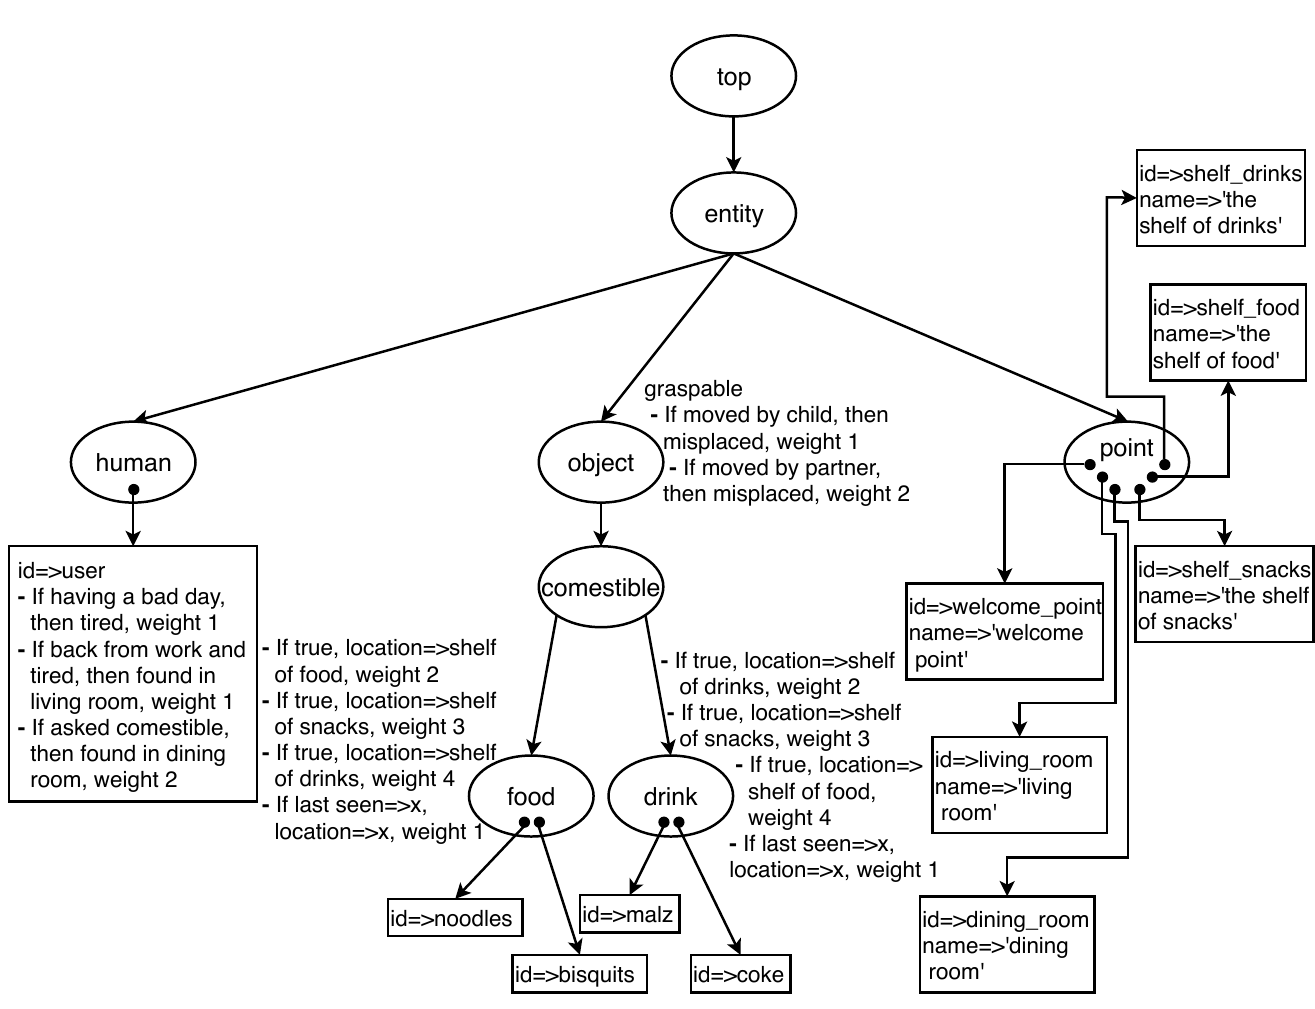
Figure 6. KB with